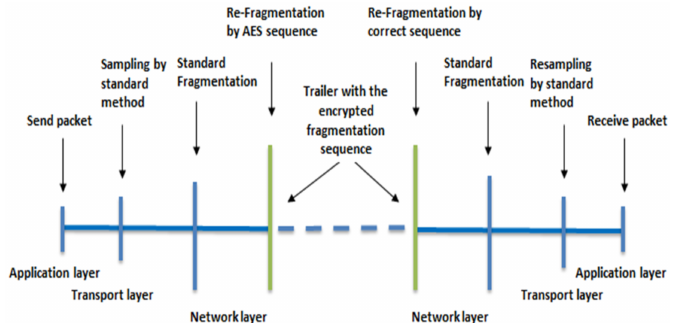
Figure 15. The security process